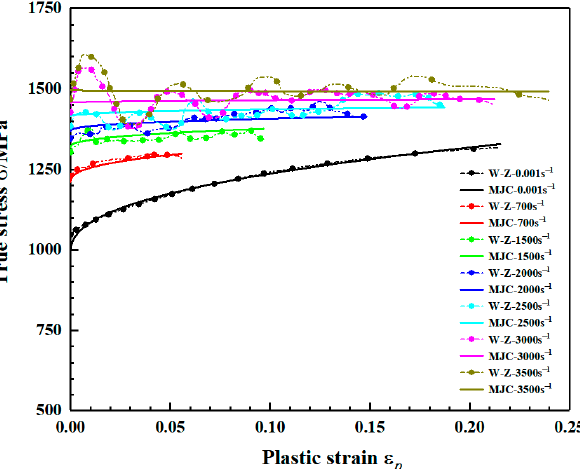
Figure 21. Comparison of flow stresses in the MJ–C model and experiments (deposition direction).